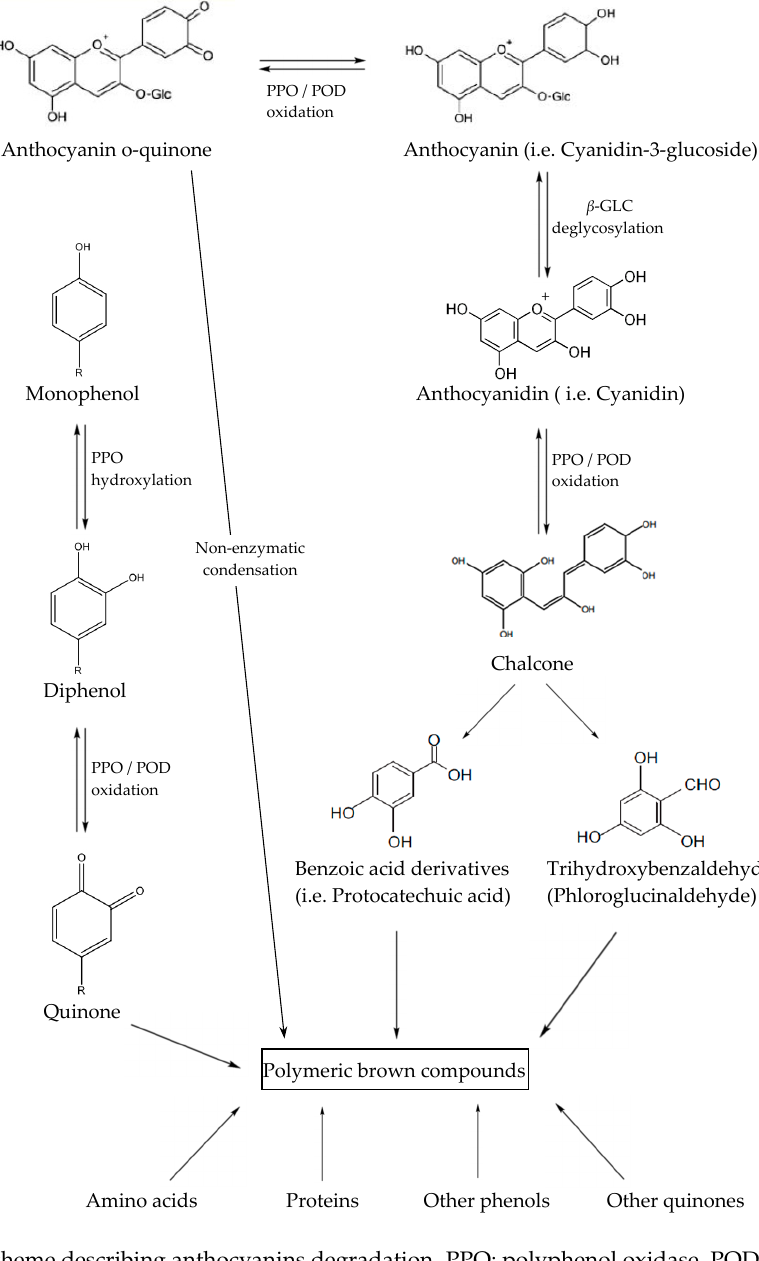
peroxidase, β -GLC: beta glycosidase 43